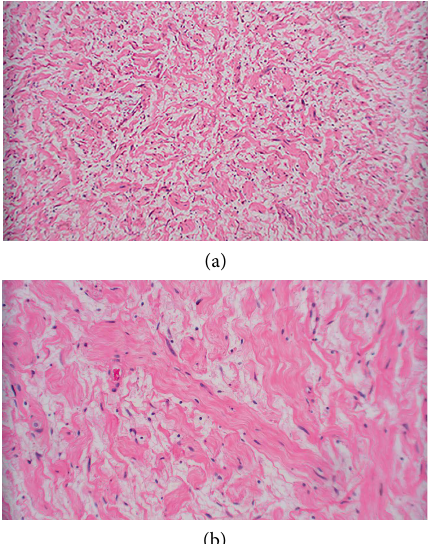
Figure 3: (a) Spindle cells arranged haphazardly in loose collagenous and pale myxoid stroma (100x). (b) Spindle cells with wavy nuclei